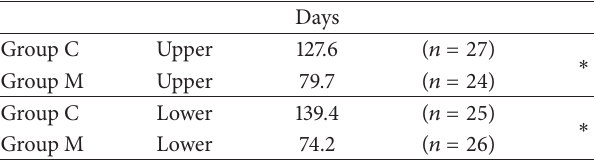
Table 1: Mean treatment period until leveling